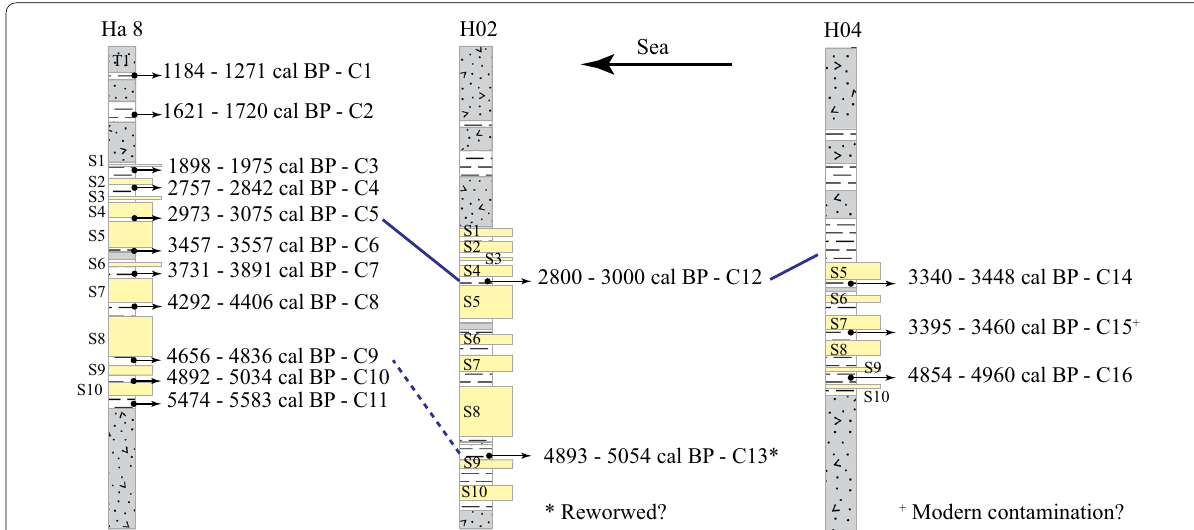
Fig. 13 Carbon dating results and ages correlation among core samples H02, Ha8, and H04. C# notation corresponds to the sample number described in the dating model on Fig. 12 and Table 4